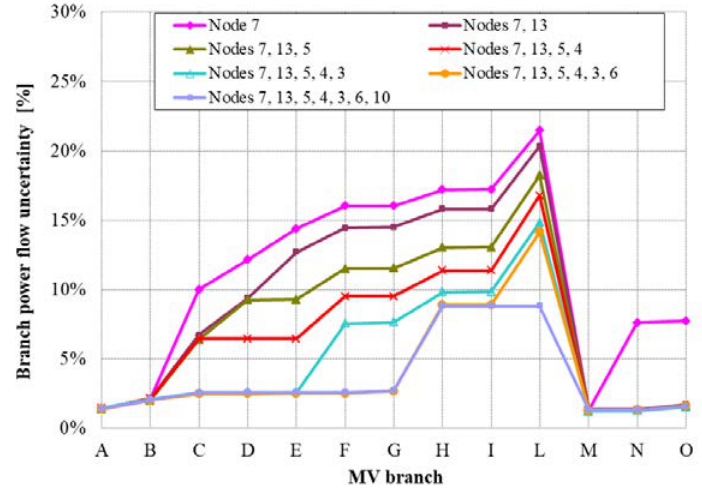
Figure 5. Branch power flow uncertainties (referring to the total power of the Vittorio Emanuele feeder) obtained when the number and position of PMs are changed.